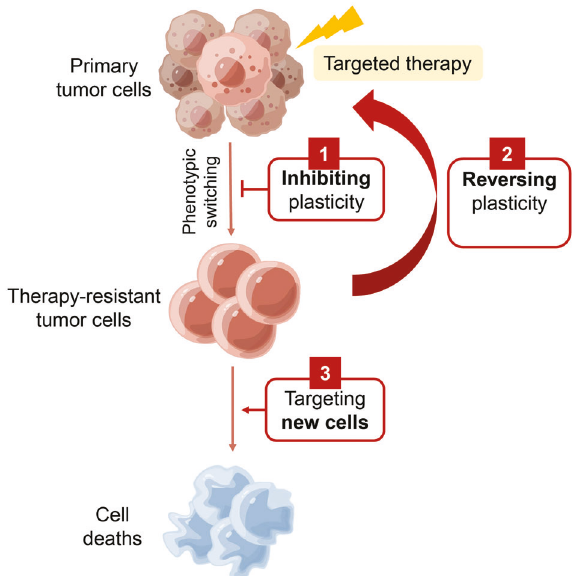
Fig. 4 Therapeutic strategies targeting tumor cell plasticity. Three main strategies can be used in combination treatment against tumor cell plasticity: 1) prevent tumor cell plasticity; 2) reverse the phenotypic switching; and 3) direct therapy to target the